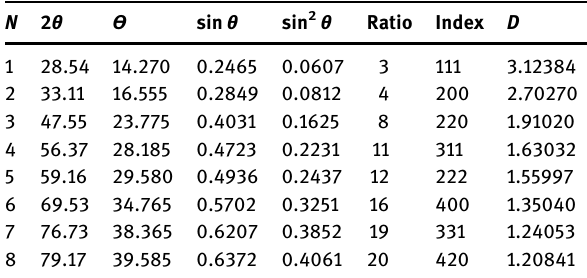
Table 1: Miller indices of the XRD peaks